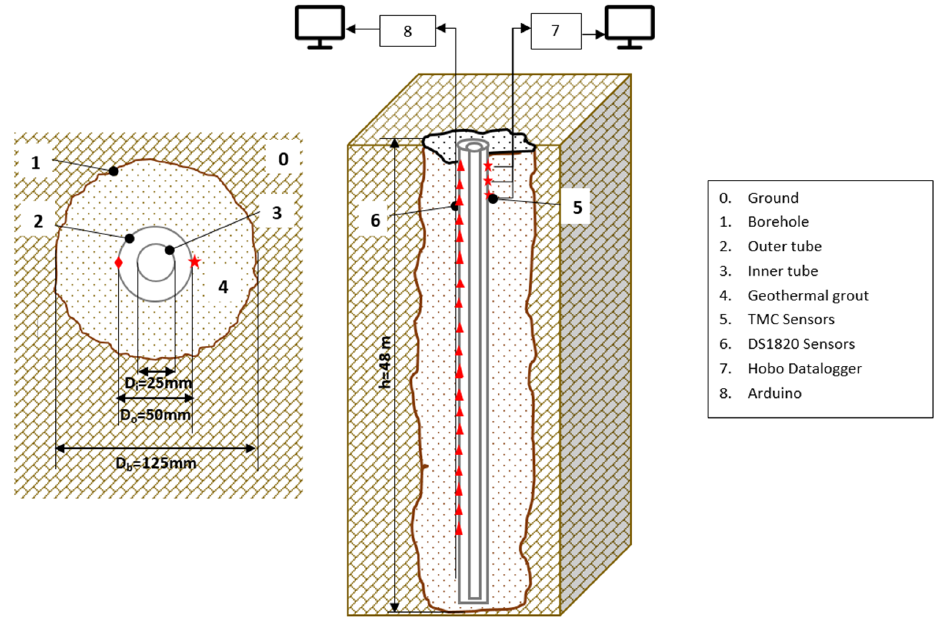
Figure 4. Experimental set-up showing the geothermal borehole, coaxial pipe, temperature sensors, grout, and a cross section of geothermal borehole Q-Thermie Uniovi-1 (figure not to scale). Red triangle corresponds to number 6. Red star corresponds to number 5.